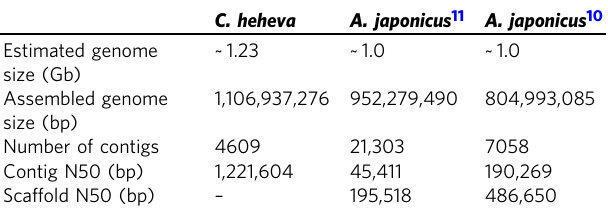
Table 1 Genome assembly statistics of deep-sea holothurian ( C. heheva ) and shallow-water holothurian ( A. japonicus